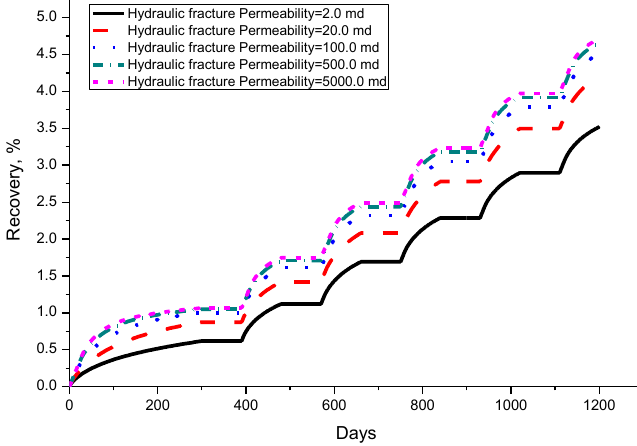
Figure 11. Recovery of different hydraulic fracture permeabilities.